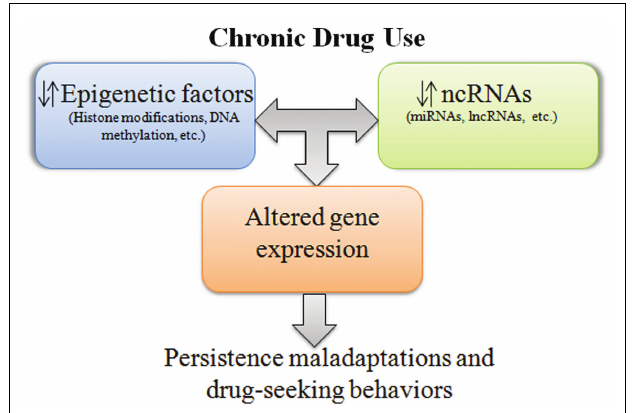
FIGURE 1 | Simplified representation of ncRNA–epigenetic interactions in response to chronic drug use. Long-term use of drugs alters expression of ncRNAs, epigenetic factors, and the interactions between these processes, causing persistent perturbations in gene expression. Chronic aberrations in gene expression are thought to evoke maladaptive neuroadaptations associated with addiction.